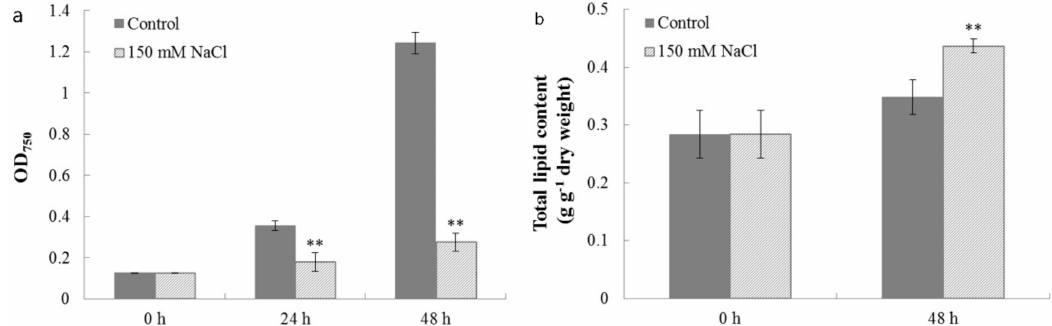
Figure 5. The effects of salt stress on ( a ) cell growth and ( b ) total lipid content of C. reinhardtii . Cell samples harvested after 0, 24, and 48 h cultivation from both the salt treatment and the control were used for measurements of cell growth and lipid content. Each value is the mean ± SD of three biological replicates. Asterisks indicate statistical significance (* 0.01 < p < 0.05, ** p < 0.01) between control and salt-treated cells according to the Tukey’s test.